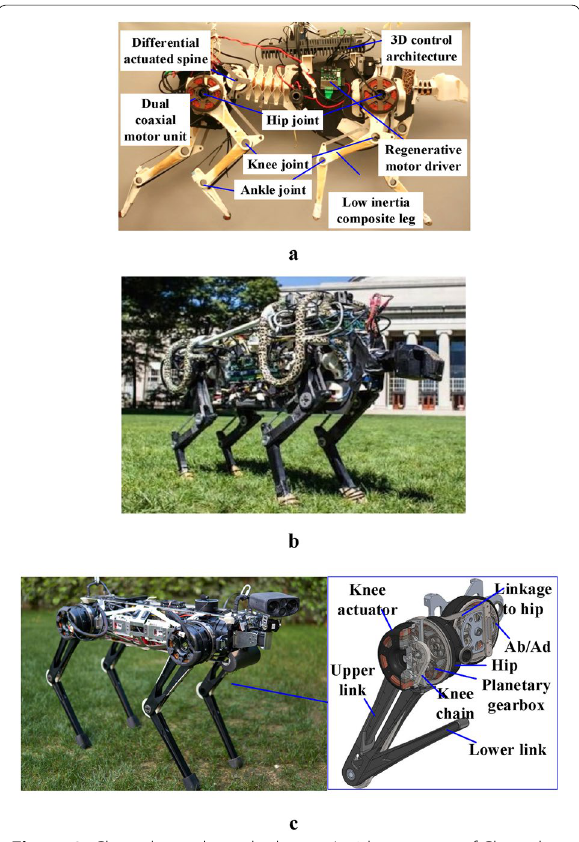
Figure 3 Cheetah quadruped robots: a Inside structure of Cheetah 1 [22]; b Cheetah 2 [23]; c Cheetah 3